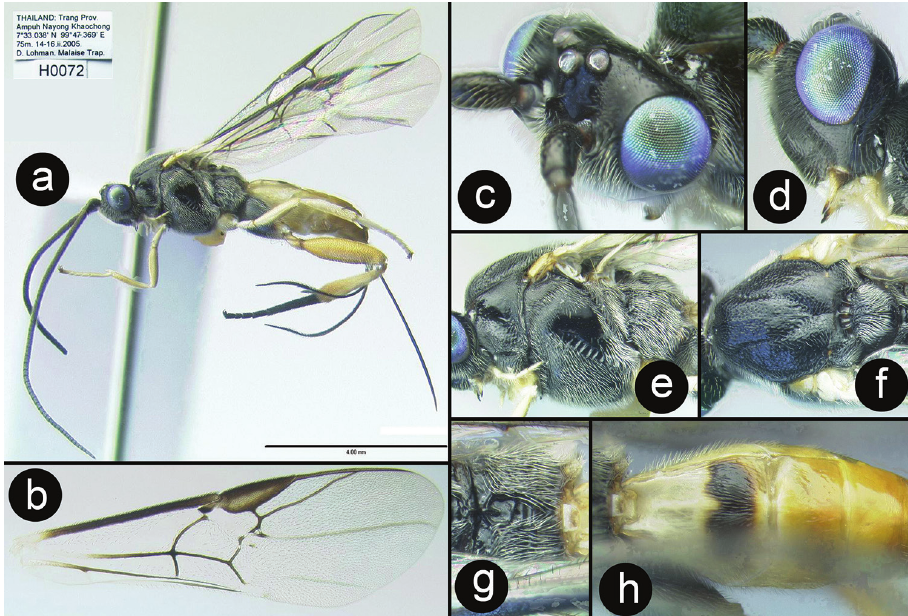
Figure 7. Chimaeragathis lohmani . a and c–h Holotype female b fore wing of paratype H412 c antero- lateral head d lateral head e lateral mesosoma f dorsal thorax g propodeum h metasomal terga 1-3. half. Antennal sockets not margined with carinae. Interantennal space with a flat triangular elevation that narrows to a short ridge posteriorly approaching the median ocellus. Temple rounded in dorsal view. Third labial palpomere not greatly reduced, more than 1/2 as long as apical palpomere. Notauli depressed and partly or entirely pitted. Scutellar triangle with dense punctures or aciculations. Ventral margin of hind coxal cavities situated below dorsal margin of metasomal foramen. Pegs on anterior surface of fore tibia present. Hind trochan- tellus lacking longitudinal carinae. Second submarginal cell of fore wing minute, cell about the same diameter as wing veins. First median tergite evenly and completely covered in strong striae, lateral carinae strong but partly obscured by sculpture. Second median tergite wider than long. Second median tergite entirely covered with strong striae that end evenly at apex of tergite; striae forming semicircular pattern anteromedially . Distribution and diversity. Known only from the type species in Thailand but probably widespread throughout Southeast Asia. Biology. Unknown